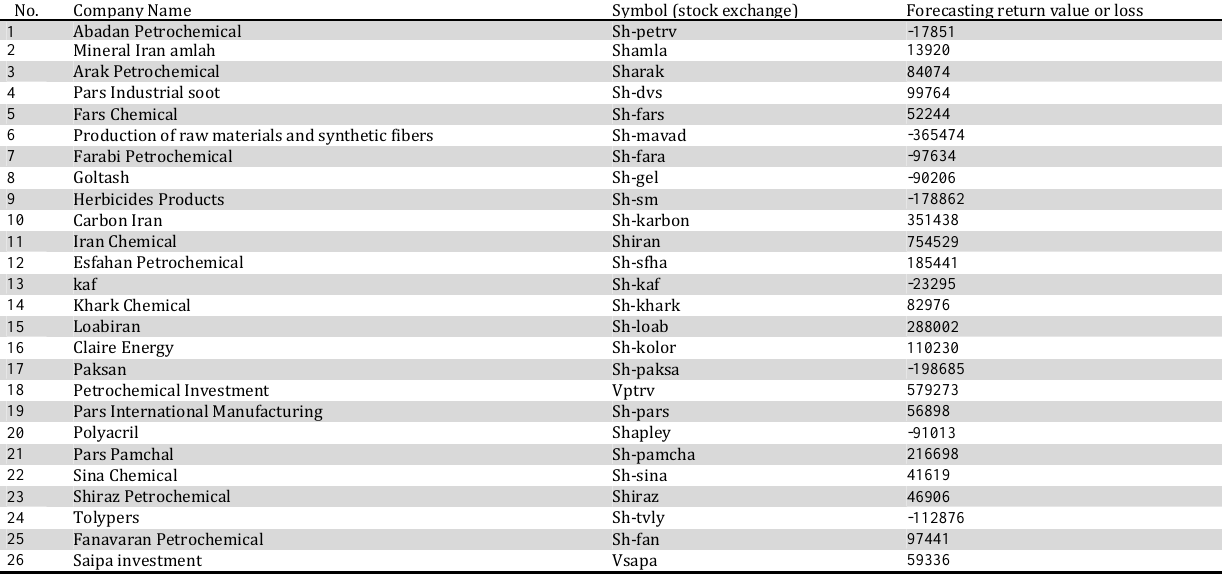
Return Value Forecasting or loss for the Next